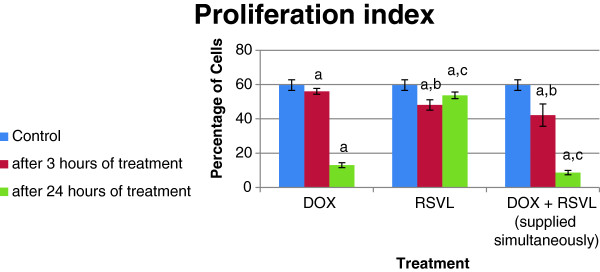
Effect of DOX and/or RSVL on the proliferation index. aSignificantly different from Control at P-value ≤ 0.05. bSignificantly different from DOX after 3 h of treatment at P-value ≤ 0.05. cSignificantly different from DOX after 24 h of treatment at P-value ≤ 0.05.